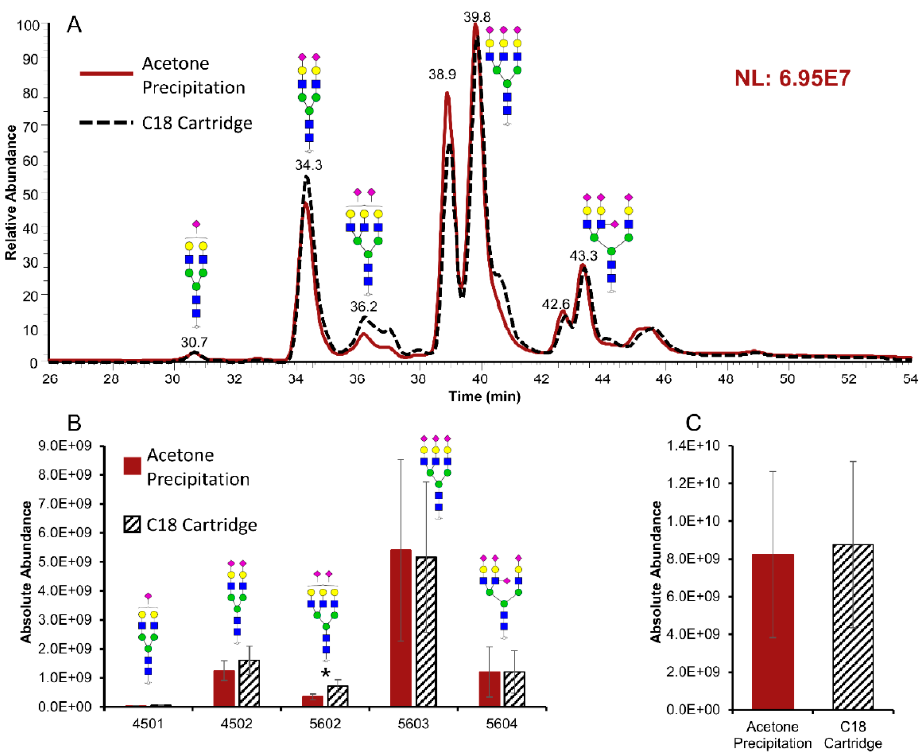
Figure 1. ( A ) Extracted Ion Chromatograms (EICs) of permethylated N -glycans derived from bovine fetuin treated by acetone precipitation (red trace) and C18 cartridges (black trace). ( B ) Quantification of N -glycans based on the area under the peak (n = 3, *: p < 0.05). ( C ) Total abundance of N -glycans detected in the samples prepared by acetone precipitation and C18 cartridges. Symbols: , N- acetylglucosamine (GlcNAc); , Galactose (Gal); , Fucose (Fuc); , Mannose (Man); , , Glucose (Glc);